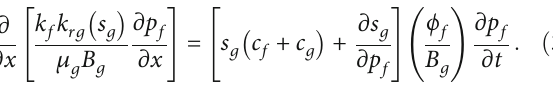
Figure 2: Geometry of complex fracture networks.